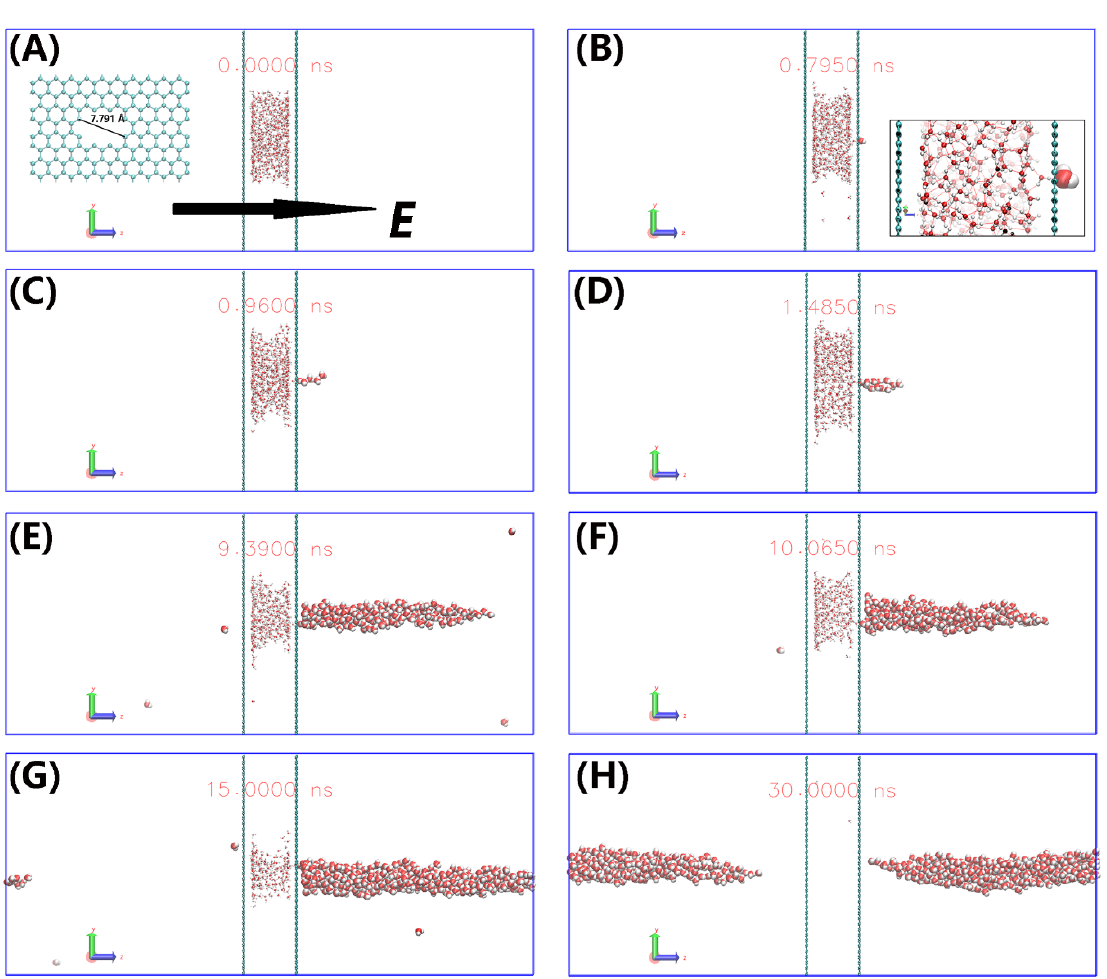
Figure 5. The dewetting process for the case of Pore-I under E = 3.0 V / nm and 300 K at 0 ns ( A ), 0.79 ns ( B ), 0.96 ns ( C ), 1.485 ns ( D ), 9.39 ns ( E ), 10.065 ns ( F ), 15.0 ns ( G ) and 30.0 ns ( H ), respectively. Gray spheres represent carbon atoms and red spheres and green spheres represent the oxygen and hydrogen atoms of a water molecule, respectively. The big spheres represent the water in a vacuum chamber.